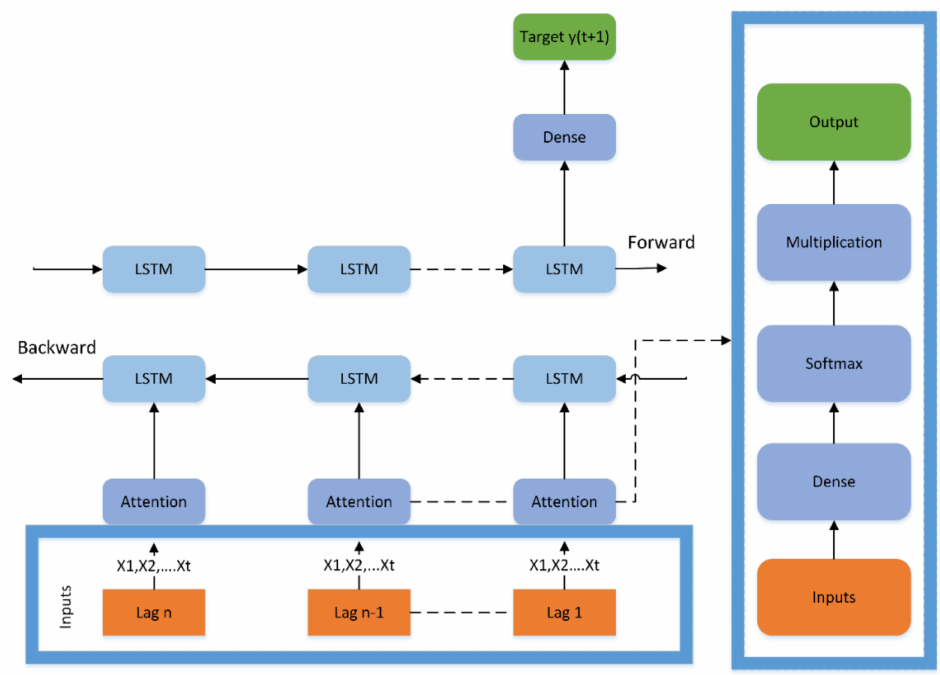
Figure 1. BiLSTM network using attention